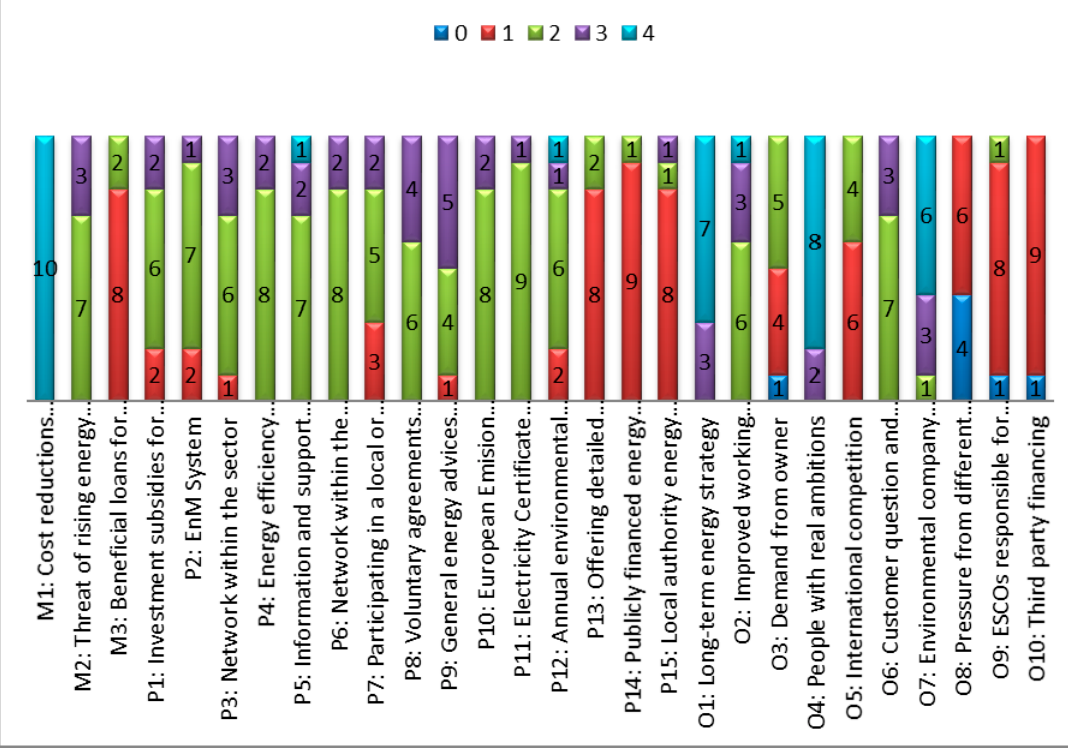
Figure 2. EE promoting factors (inspired from Thollander and Ottosson [18] and Brunke et al. [13]).